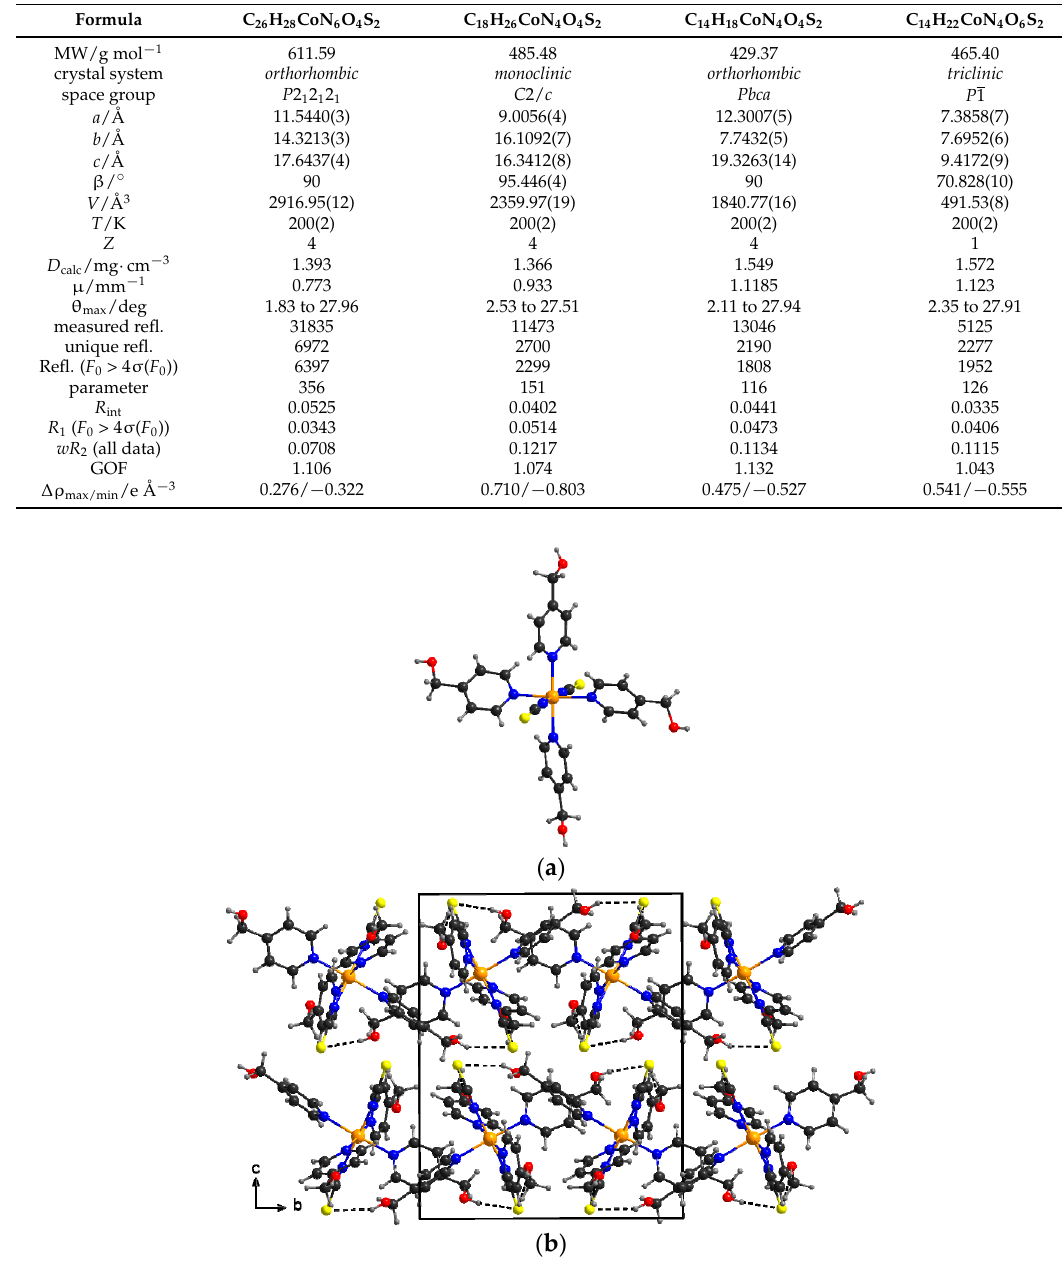
Figure 1. Crystal structure of 1 with view of the coordination sphere ( a ) and along the crystallographic a axis with intermolecular hydrogen bonding shown as dashed lines ( b ). The ORTEP plot is shown in Figure S1 in the Supplementary Material.